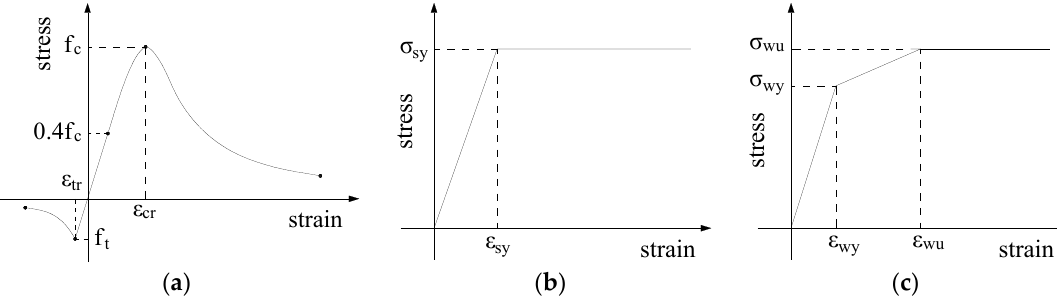
Figure 14. Constitutive relationship in finite element analysis (FEA): ( a ) Concrete, ( b ) steel bar, ( c ) steel mesh.